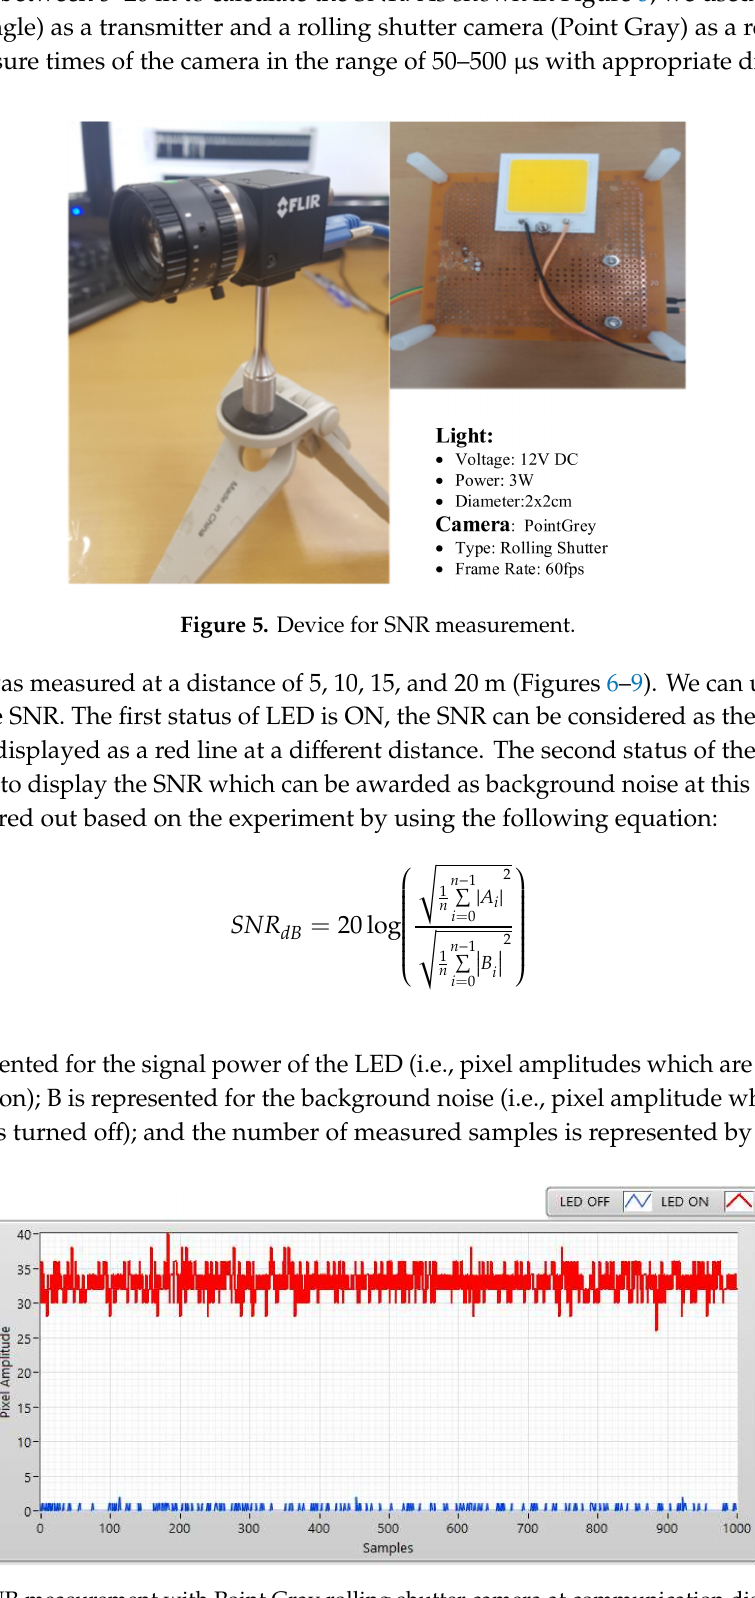
Figure 6. SNR measurement with Point Gray rolling shutter camera at communication distance of 5 m and exposure time of 50 µ